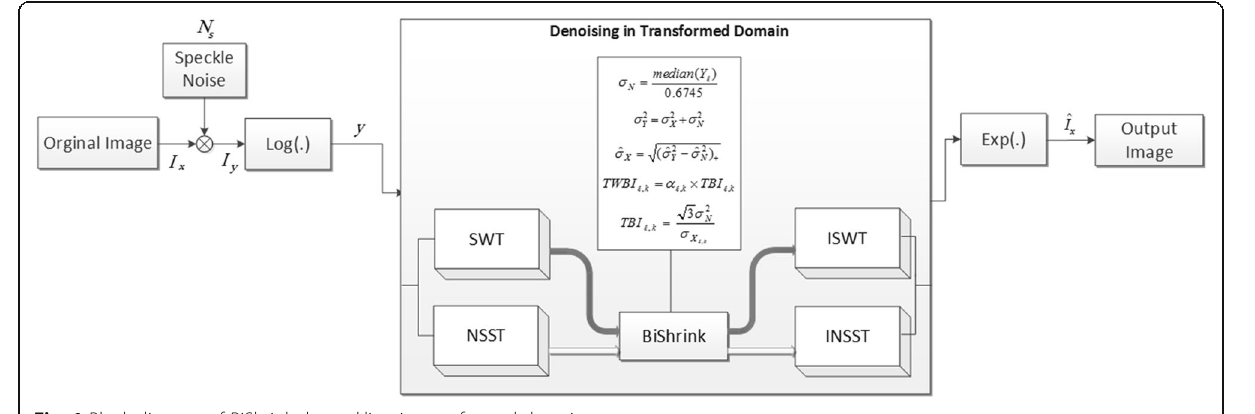
Fig. 1 Block diagram of BiShrink despeckling in transformed